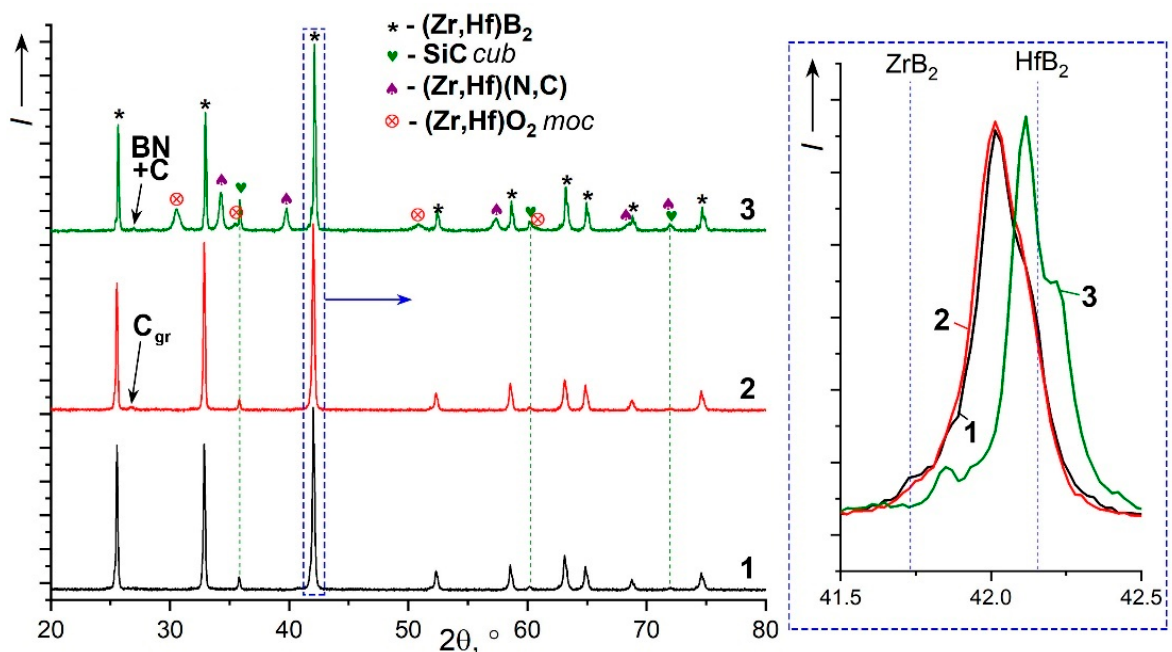
Figure 2. X-ray diffraction patterns of ZHS (1), ZHSC (2), and the surface of the ZHSC sample after exposure to a supersonic flow of dissociated nitrogen (3); the inset area in the range 2 θ = 41.5–42.5°, in which the position of the maximum intensity reflexes of ZrB 2 [66] and HfB 2 [67]. The study of the obtained materials using Raman spectroscopy made it possible to establish (Figure 3) that for both ZHS and ZHSC, intense modes of cubic silicon carbide with maxima at 801 (TO) and 976 cm − 1 (LO) are observed, while ZrB 2 and HfB 2 are inactive in the Raman spectra. Some shifts in the position of the modes to the region of large shifts, with respect to the values 784–804 (for TO) and 968–975 cm − 1 available in the literature [44,69–71], may be due to the high compressive stress concentrated in the ceramic on the SiC grains [72,73]. For the ZHS sample, the presence of some amount of impurity carbon is shown, which is expressed in the presence of two low-intensity broadened bands with maximums in the 540–550 and 600–610 cm − 1 region, associated with amorphous carbon, as well as D- and G-peaks. The introduction of multilayer CNTs into the ZHSC sample resulted in the appearance of their characteristic peaks with maxima in the range of 1351–1361 (D-mode) and 1578–1594 cm − 1 (G-mode) [39,40,44–46,74,75], overlapping with those characteristics of the impurity amorphized carbon remaining after the SiC carbothermic synthesis. The observed local maximum at 1619 cm − 1 may be related to the presence of defective sp 2 carbon atoms at the ends of the aggregates of multilayer nanotubes. SEM of thin sections of ZHS and ZHSC samples, performed at an accelerating voltage of 2 kV to increase the contrast, showed that the grain size of the boride phase was 2–3 µ m, and silicon carbide–~1–1.5 µ m (Figure 4). At the same time, relatively large aggregates of the zirconium–hafnium diboride phase up to 5–10 µ m in size were found for the ZHS sample. In this case, as evidenced by the mapping of Si, Zr, and Hf element distributions (Figure 5), the core of such formations is a ZrB 2 -based solid